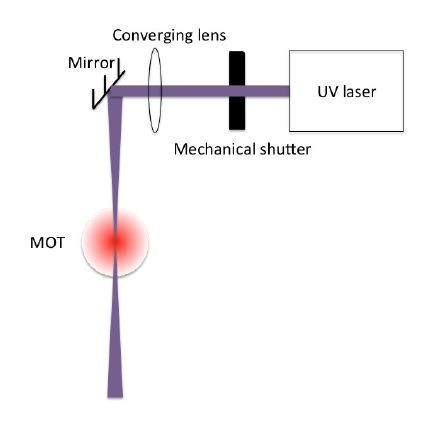
Figure 5. The schematic plot of this